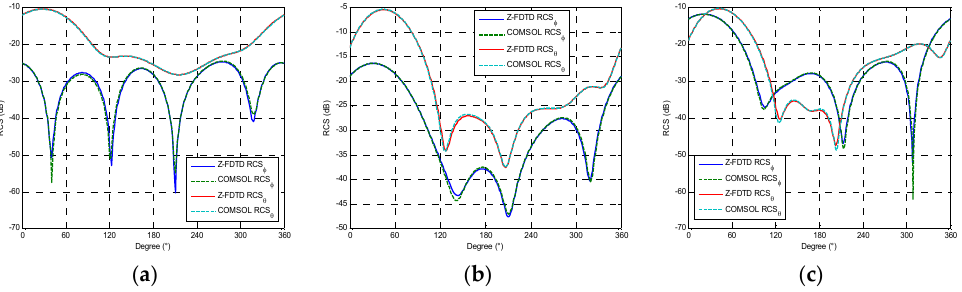
Figure 6. RCS results of single brick at the frequency point f = 1 GHz: ( a ) xOy plane; ( b ) yOz plane; ( c ) zOx plane.